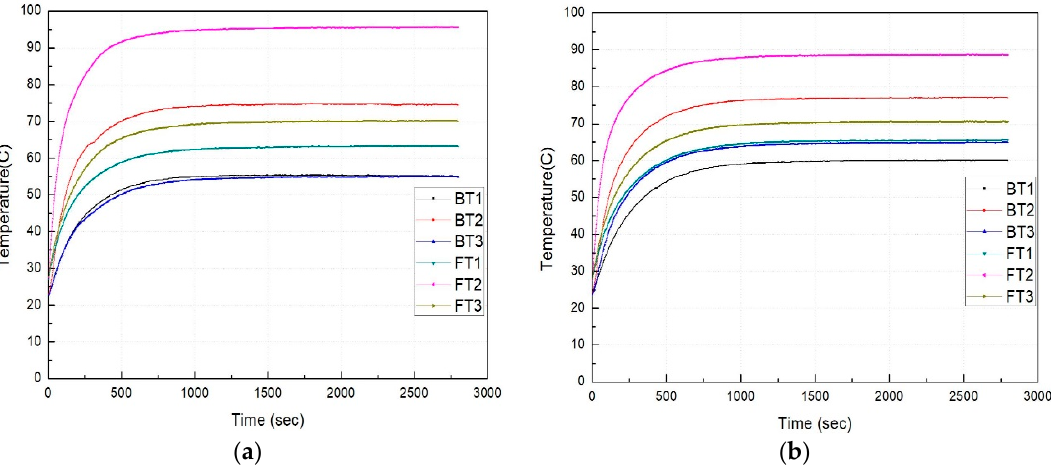
Figure 8. Reflector temperature measurement results over time: ( a ) temperature distribution of the PBT reflector, ( b ) temperature distribution of the reflector made of PA6-based composites.